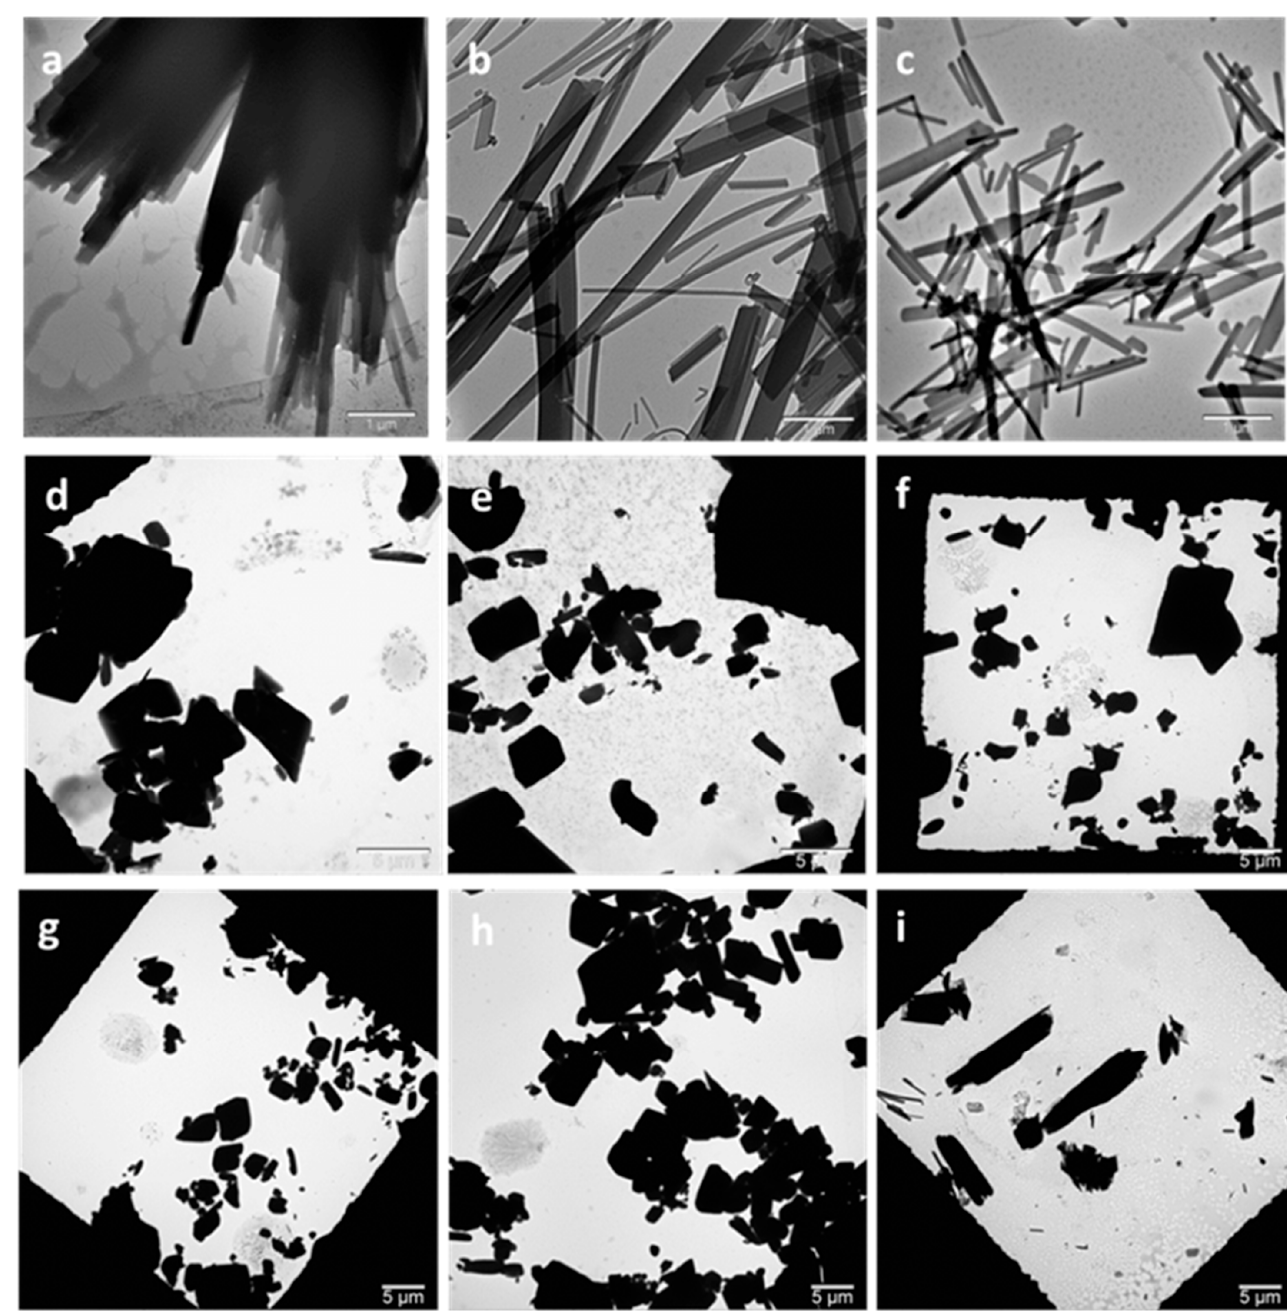
Figure 2. Transmission electron microscopy (TEM) images of HPH- and high-power ultrasound-prepared cocrystals. ( a ) HPH 300 bar 5c, ( b ) HPH 600 bar 5c, ( c ) HPH 900 bar 5c, ( d ) HPU 50% 10 min, ( e ) HPU 70% 10 min, ( f ) HPU 70% 20 min, ( g ) HPU 70% 30 min, ( h ) HPU 90% 10 min, and ( i ) control. HPH: high pressure-homogenization; HPU: high-power ultrasound; c: number of HPH cycles; percentage refers to HPU amplitude.